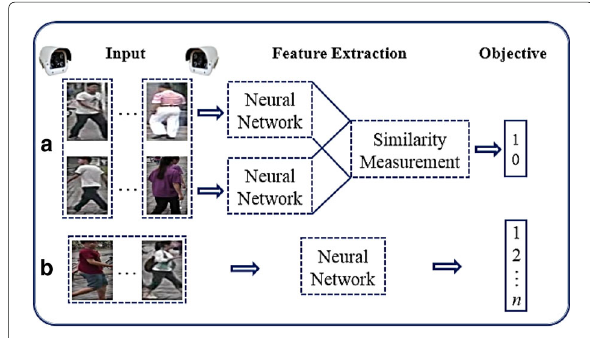
Fig. 1 The structures of a verification models and b identification models. a Verification models take pairs of pedestrian images as the input and predict whether they are the same person or not. b Identification models take pedestrian images as the input and predict their